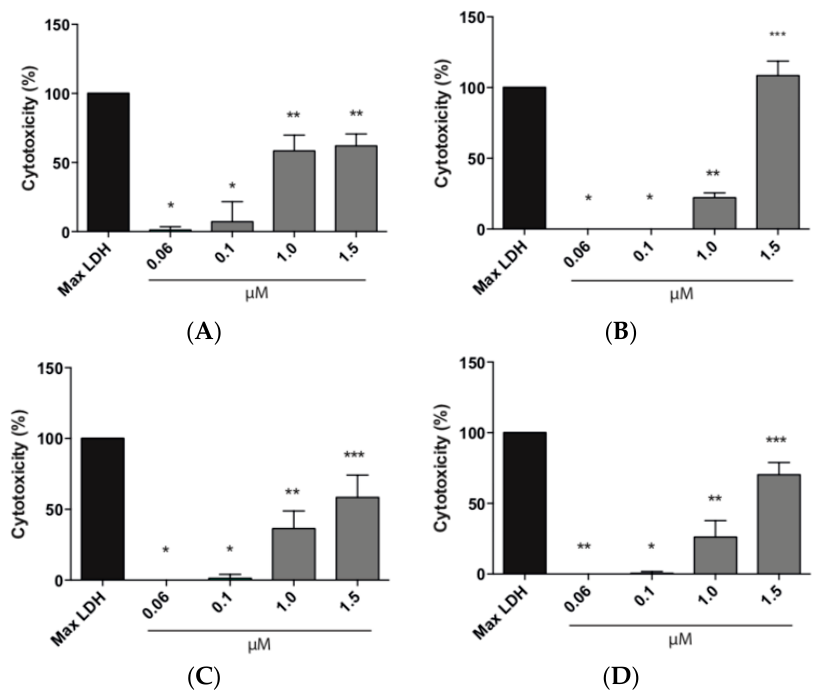
Figure 8. Total LDH release expressed as Cytotoxicity percentage of HeLa cells treated with different concentrations of EE/alginate nanoparticles compared to the Culture medium control. ( A ) TC 30 CR 0.5/ 1 h; ( B ) TC 30 CR 0.5/ 24 h; ( C ) TC 30 CR 1.33/ 1 h; and ( D ) TC 30 CR 1.33/ 24 h. ** = P < 0.01, **** = P < 0.0001.